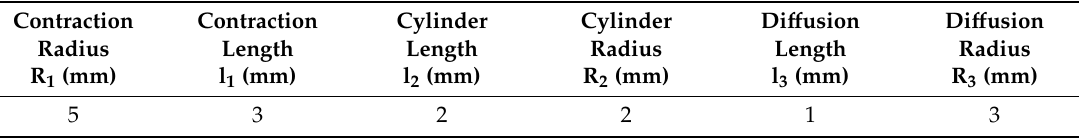
Figure 1. Structure of the different medium tool: ( a ) three-dimensional model, ( b ) two-dimensional structural model. Table 1. Structural parameters of the different medium tool.